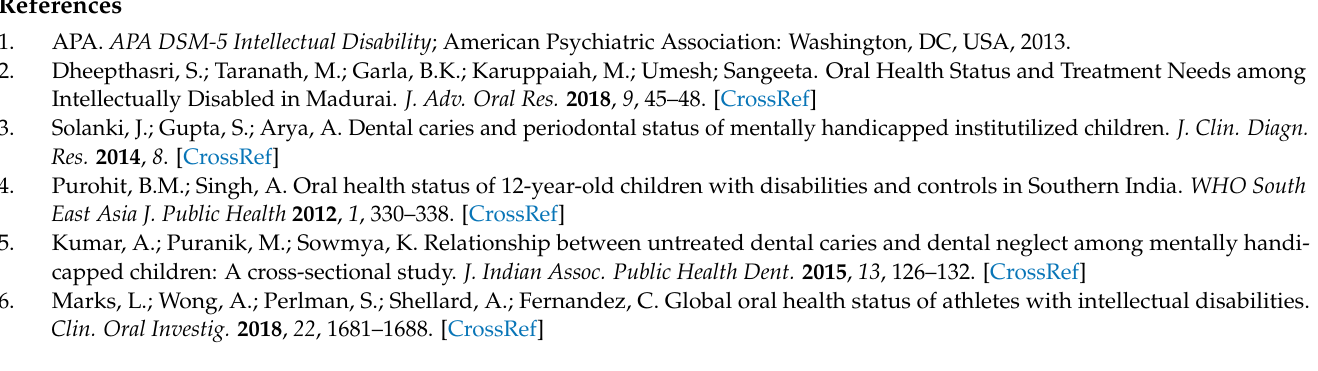
search results. Table S2. Oral health status among ID children of Asian characteristics included in the studies; Table S3. Quality Assessment of Studies (The Joanna Briggs Institute Critical Appraisal Checklist); Table S4. Risk of bias (ROBINS-E); Table S5 the DMFT index data extracted from included studies; Table S6. Plaque index data extracted from the included studies. Table S7. The oral hygiene index simplified (OHI-S) data were extracted from the included studies; Table S8. The CPITN data were extracted from the included studies; Table S9. Gingival index data extracted from the included